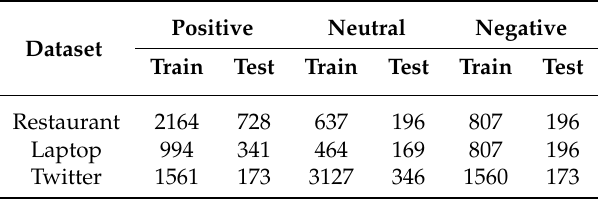
Table 1. Dataset polarity